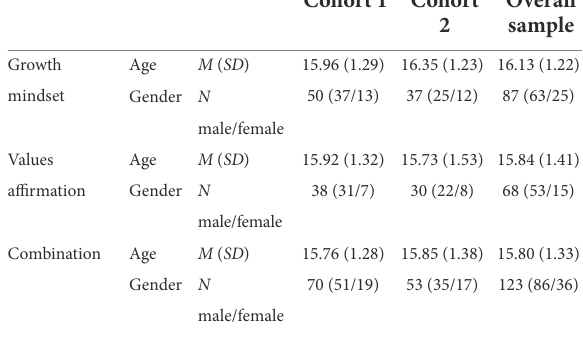
TABLE 1 Demographic data of the participants, split by intervention